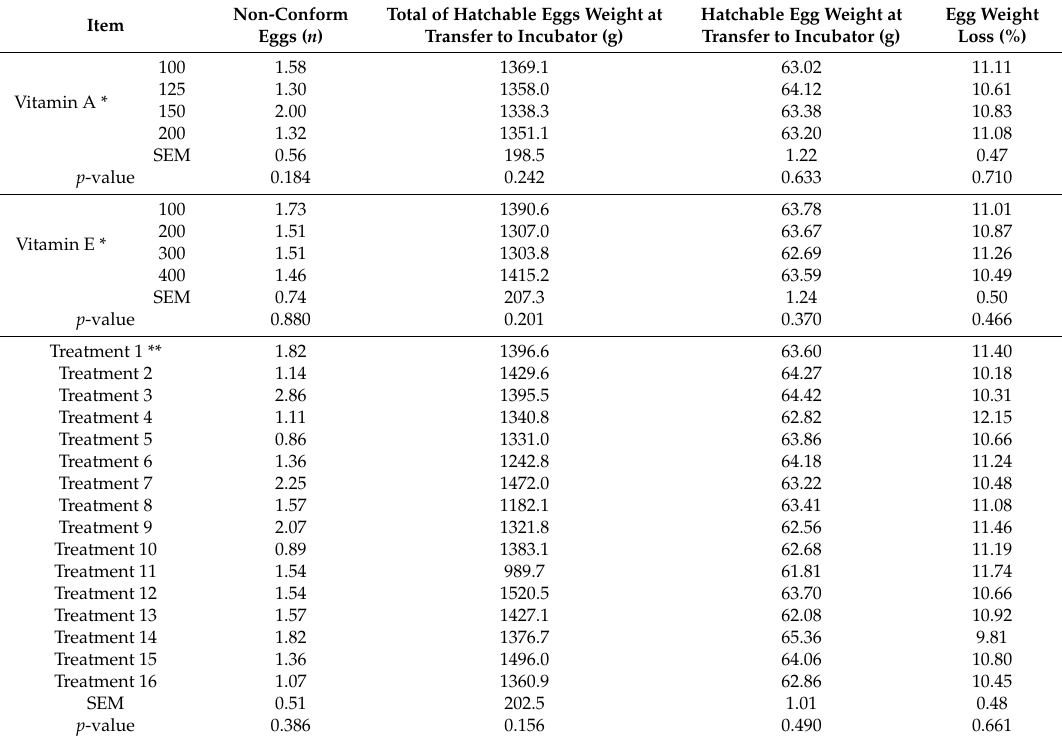
Table 3. Effect of dietary treatments on egg-related